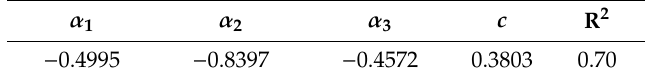
Table 5. Longitudinal Dispersion Coefficient multi linear regressing coefficients.